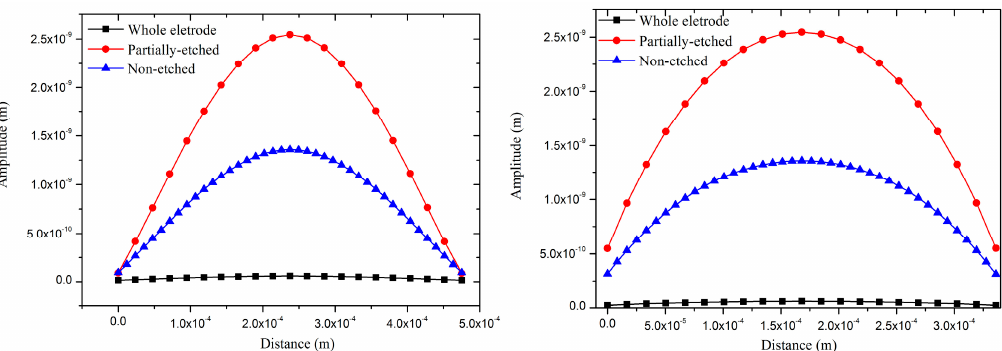
Figure 8. The amplitudes of pMUT with whole electrode, centric electrode and partially-etched ZnO films along P1 ( left ) and P2 ( right ) lines.